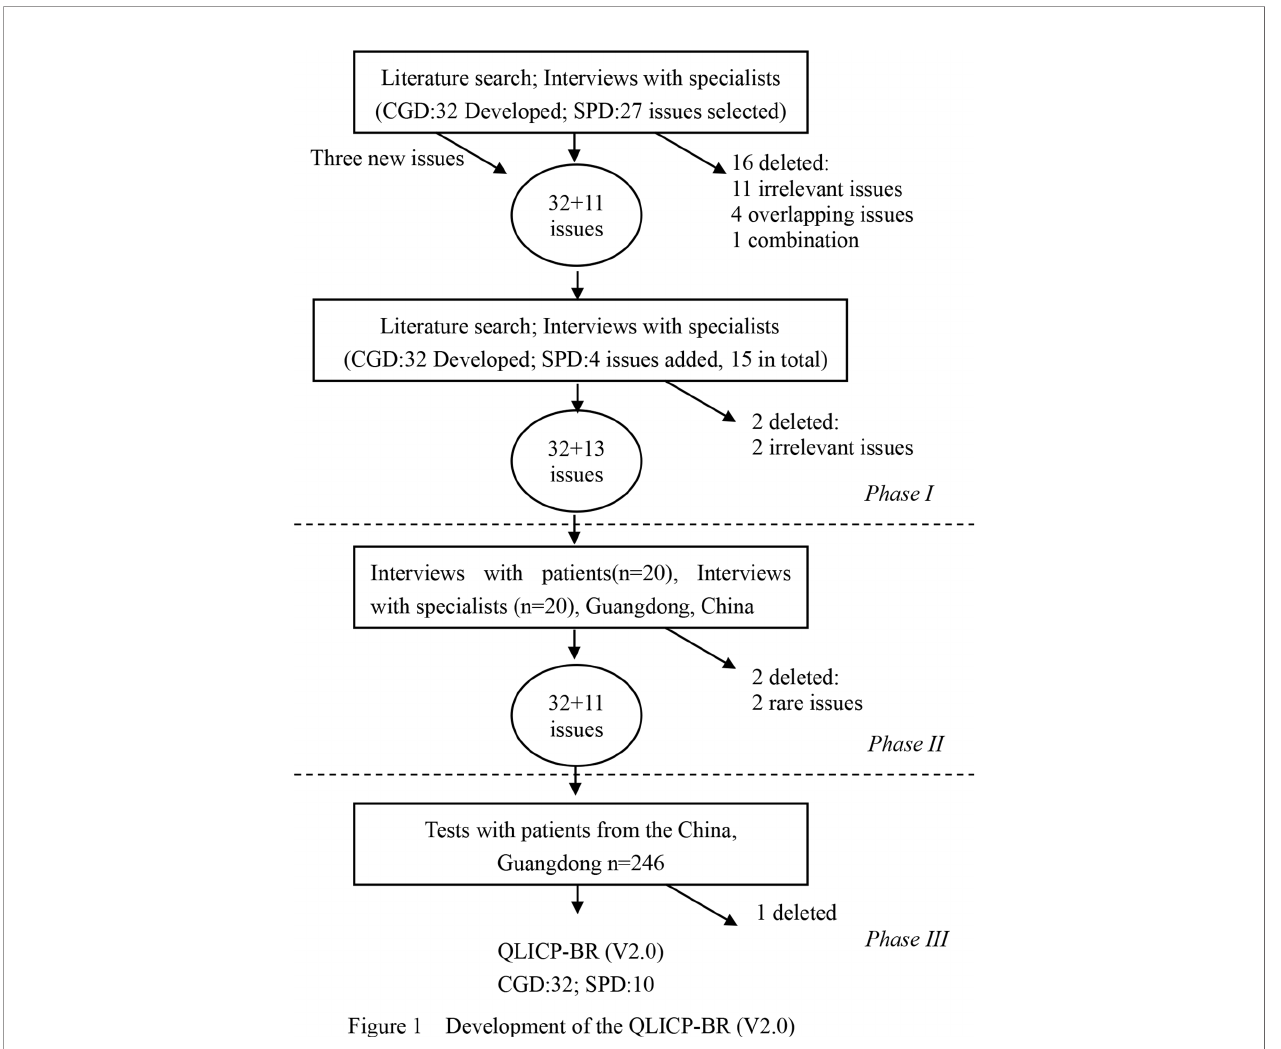
FIGURE 1 | Development of the QLICP-BR